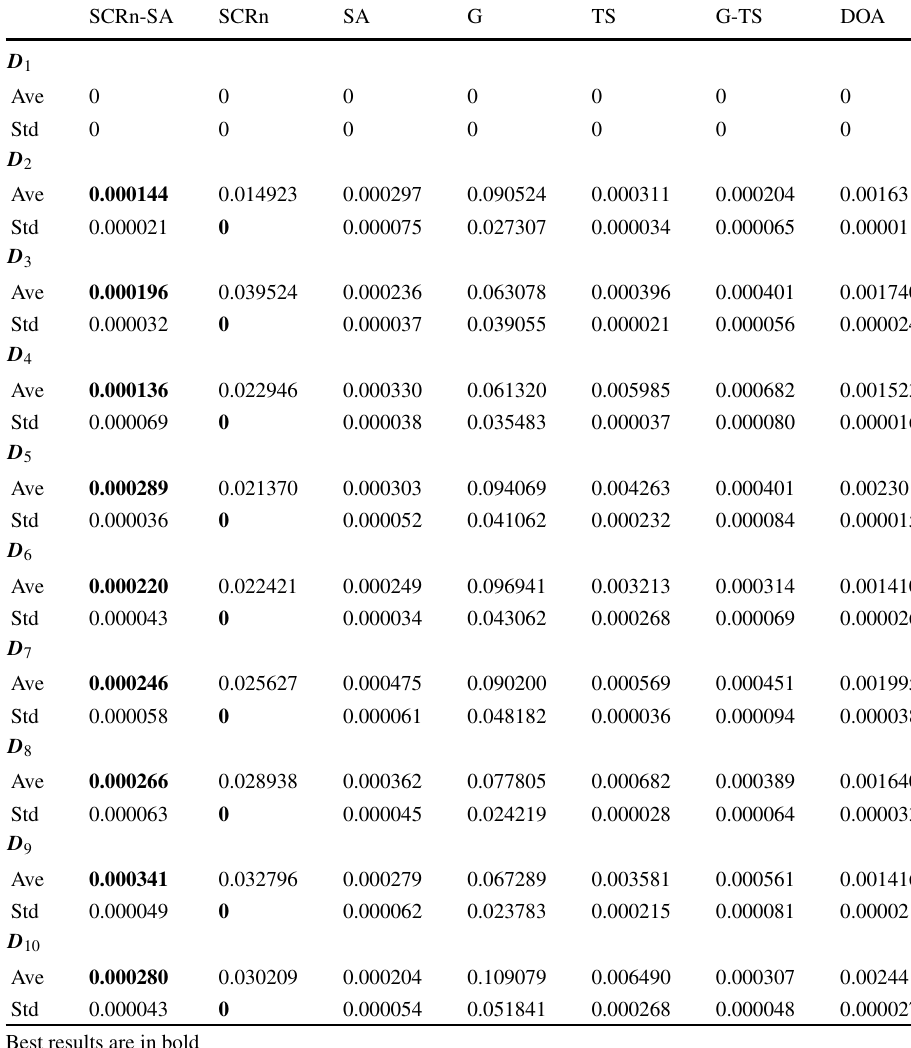
Table 8 Statistical results of SCRn-SA, SCRn, SA, G, TS, G-TS and DOA in the public dataset